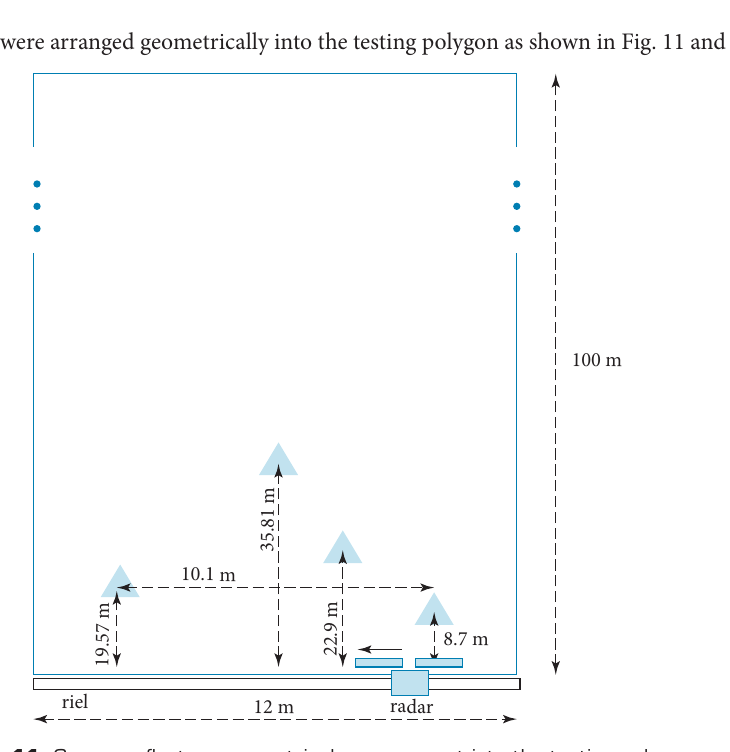
Figure 11. Corner reflectors geometrical arrangement into the testing polygon.